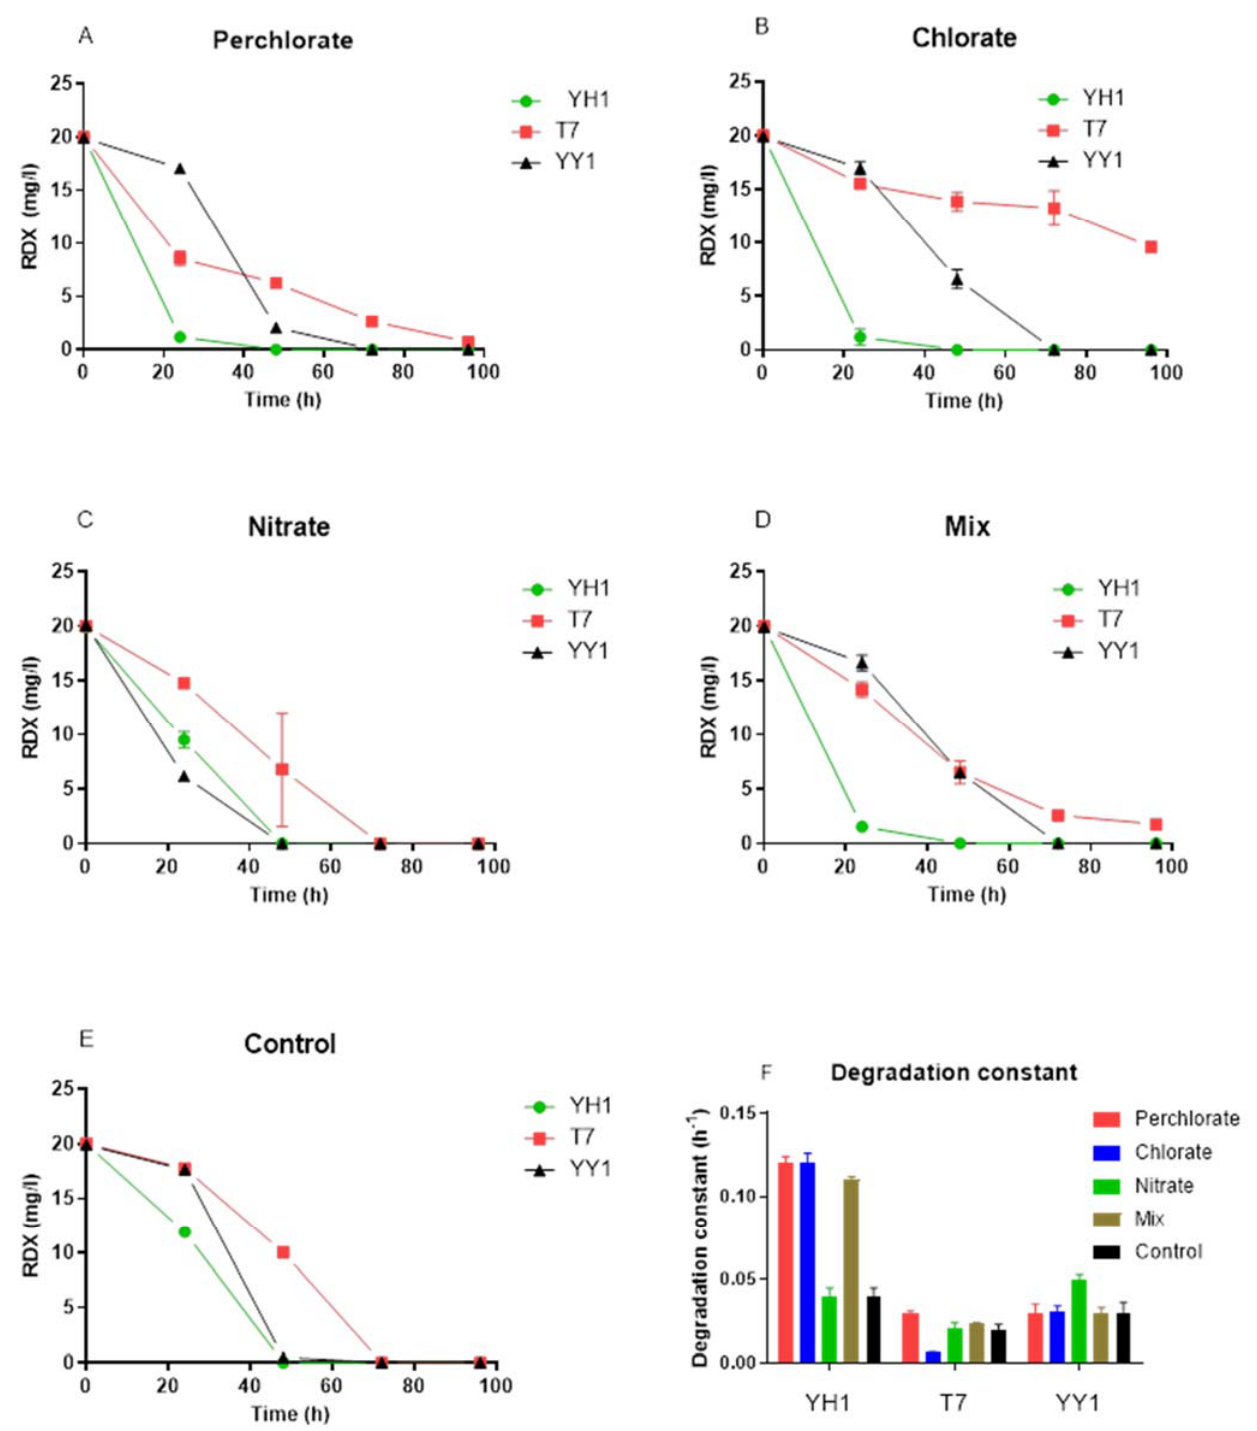
Figure 2. Effect of co-contaminants on RDX degradation rates of three strains of degraders. ( A ) Per- chlorate, ( B ) chlorate, ( C ) nitrate, ( D ) mix, ( E ) control, and ( F ) growth constant. The degradation constant was obtained from a nonlinear regression of the first-order reaction. Triplicates were used in all treatments, and the results are average ± standard deviation.